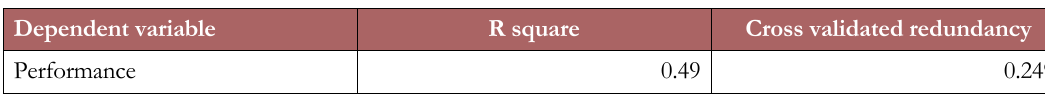
Table 7. Predictive